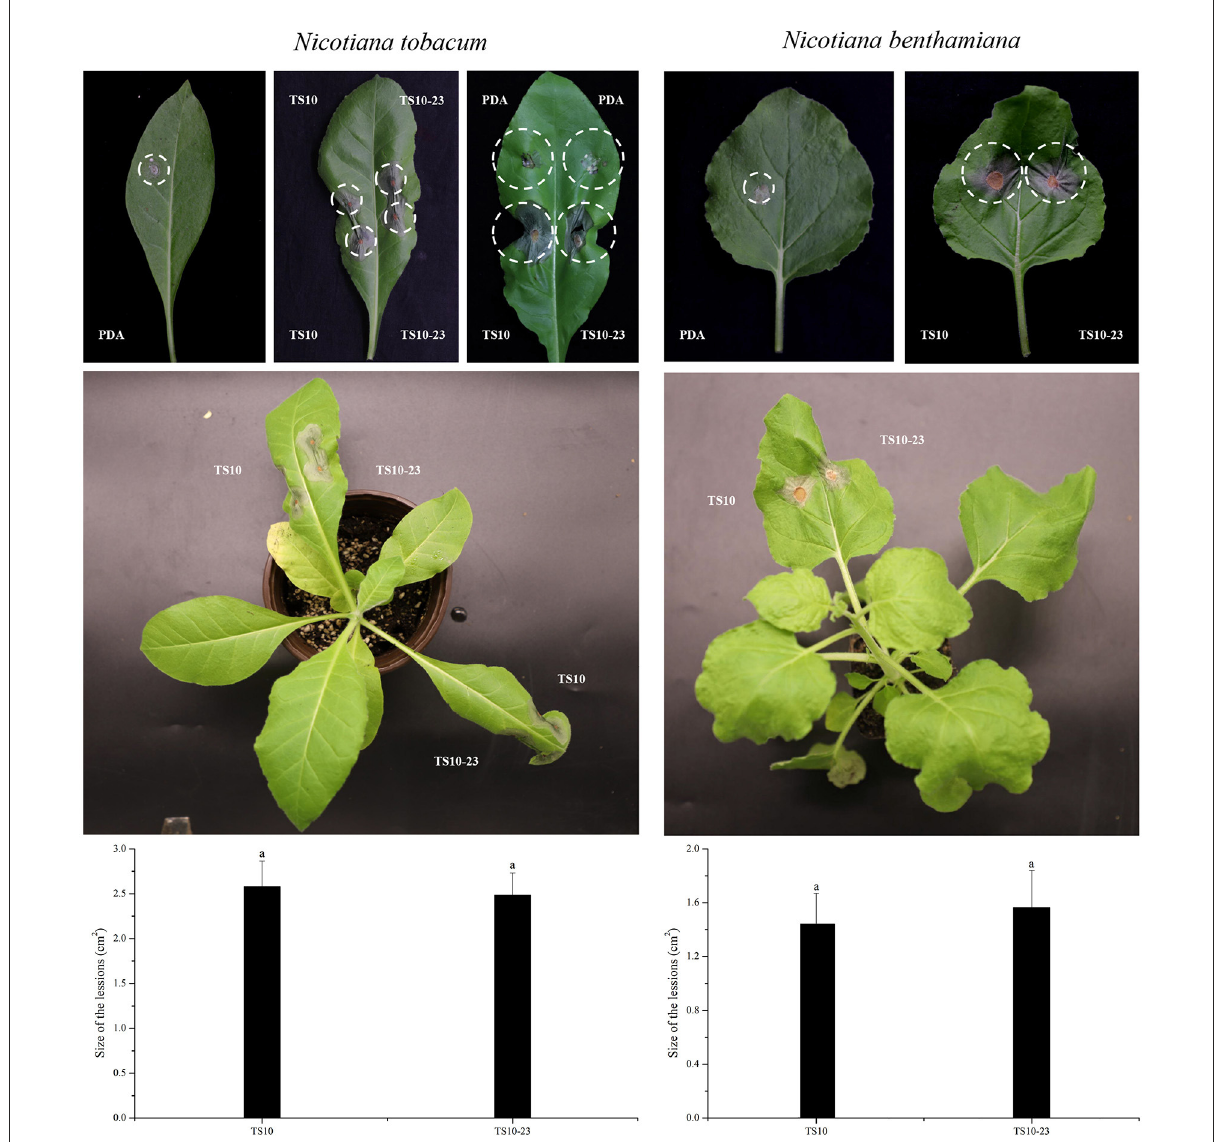
FIGURE6 Pathogenicity test of R. solani that with and without RsPV433 on N. tobacum and N. benthamiana . The pathogenicity of TS10 and TS10-23 were tested by inoculating the mycelial plugs of these two strains on N. tobacum and N. benthamiana . Symptoms were observed 4 days